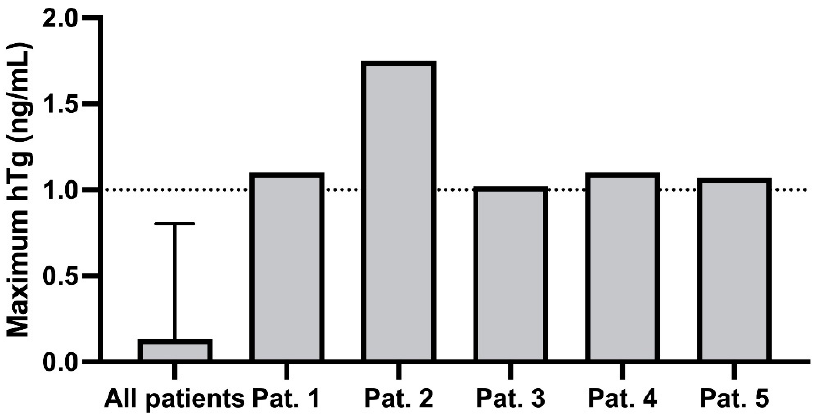
Figure 1. Maximum hTg [ng/mL] of 5 patients with increased hTg ≥ 1 ng/mL. Table 2. Development of hTg, TgAB, hTg-recovery, and TSH of 5 patients with increased hTg > 1